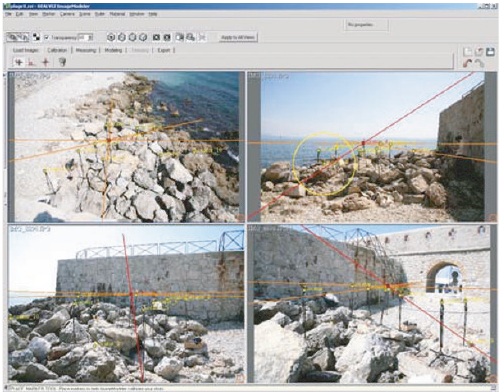
Figure 3: We retrieve the position of the microphones from several photographs of the setup using a commercial image-based model- ing tool. In this picture, we show four views of a recording setup, position of the markers and the triangulation process yielding the locations of the microphone